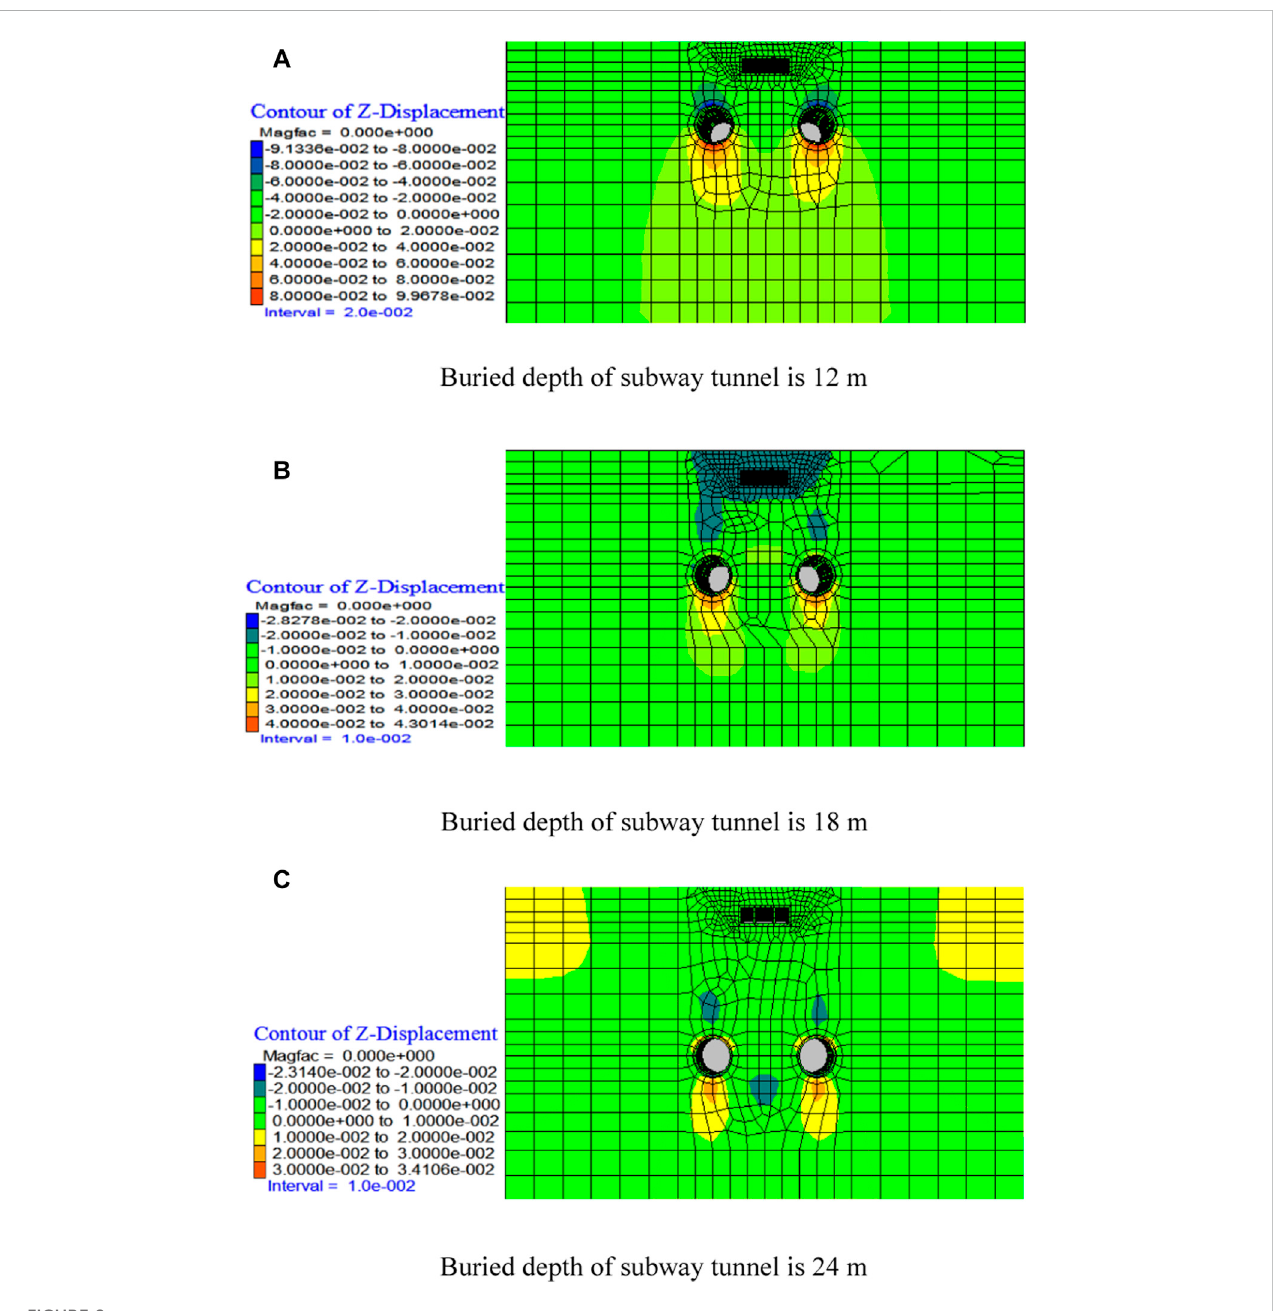
FIGURE 8 Vertical displacement diagram under different tunnel burial depths (unit: